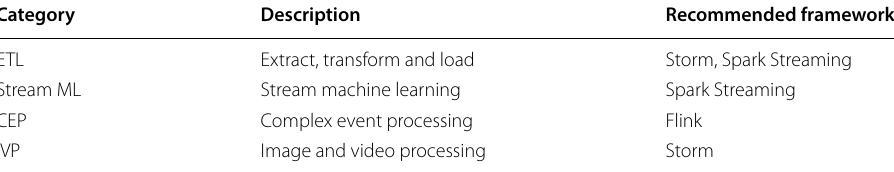
Table 2 Framework recommendation for different streaming application